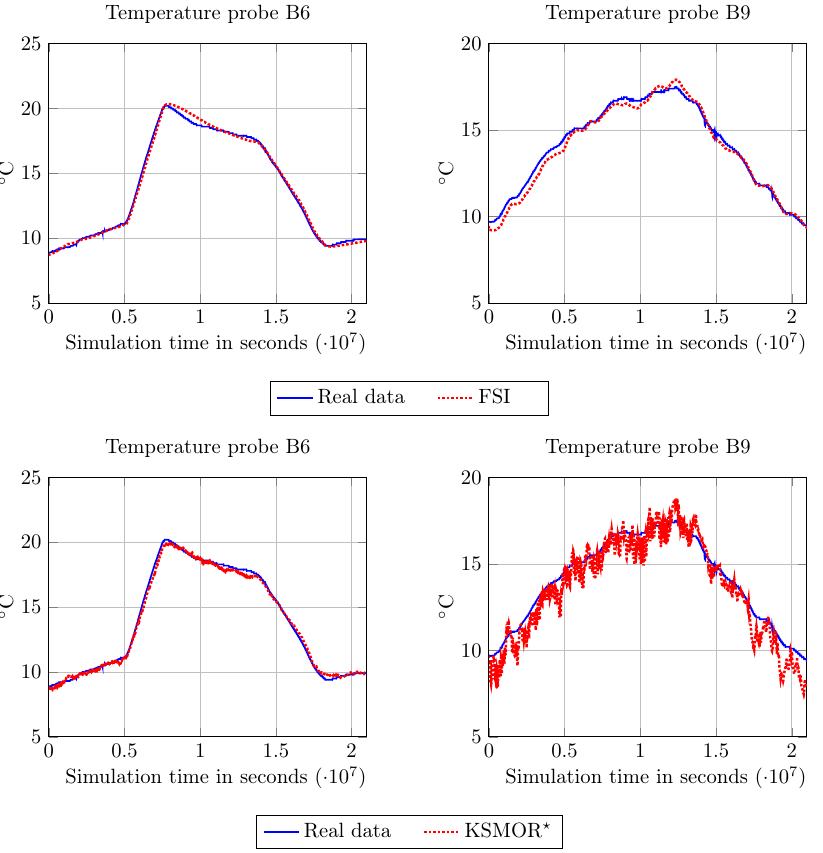
Figure 13. Results of the GES experiment for temperature probe B6 (5th from the top) and temperature probe B9 (2nd from the top) on the left and right side, respectively: visual comparison (along the temporal axis) between the real temperature from 3D field and the approximations of the 2D model computed by FSI as well as KSMOR (cid:63) . The CPU time of both computed approximations amount again to 10 s. Top: FSI for M = 220 cycles (4840 iterations). Bottom: KSMOR (cid:63) with s = 10, q = 2 for τ = 13,176 (1600 iterations). Both methods reproduce the same temperature behaviour compared to the real data; however, the corresponding temperature of the KSMOR (cid:63) technique can oscillate highly sensitive, especially in a local area around the interfaces between different